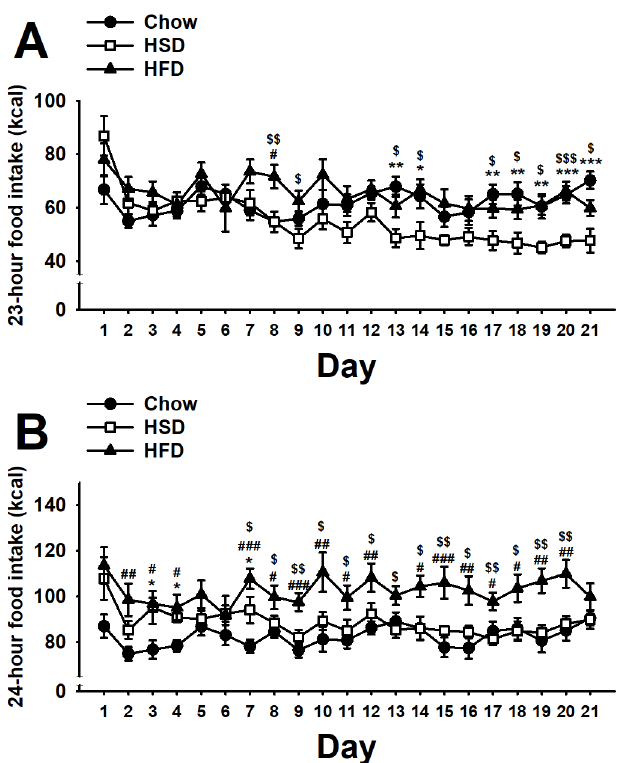
Figure 5. Effects of daily 1-h operant self-administration of Chow, HSD, or HFD on ( A ) 23-h home-cage food intake (kcal), and ( B ) 24-h food intake (kcal) in female Sprague Dawley rats ( n = 10/group). Rats were given the chance to self-administer one of the three diets in a fixed ratio 1 schedule during a 21-day period. Chow was otherwise freely available in the home cages. Panels represent M ± SEM. Symbols denote the following: * HSD differs from Chow, p < 0.05, ** p < 0.01, *** p < 0.001; # HFD differs from Chow, p < 0.05, ## p < 0.01, ### p < 0.001; $ HSD differs from HFD, p < 0.05, $$ p < 0.01, $$$ p < 0.001 (Newman–Keuls test).